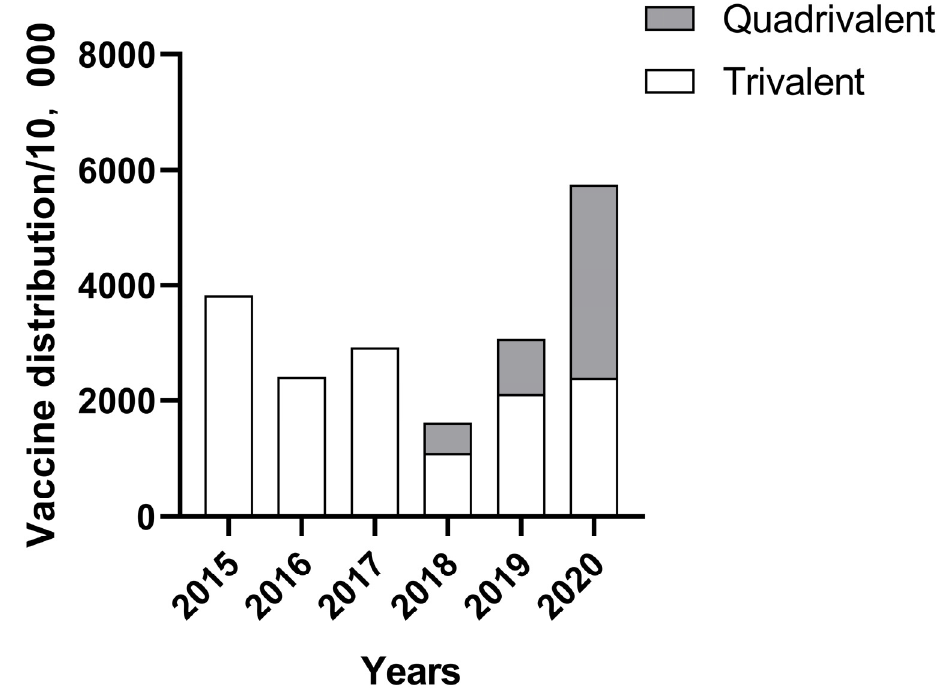
Figure 2. China’s influenza vaccine industry batch issue volume in recent years.